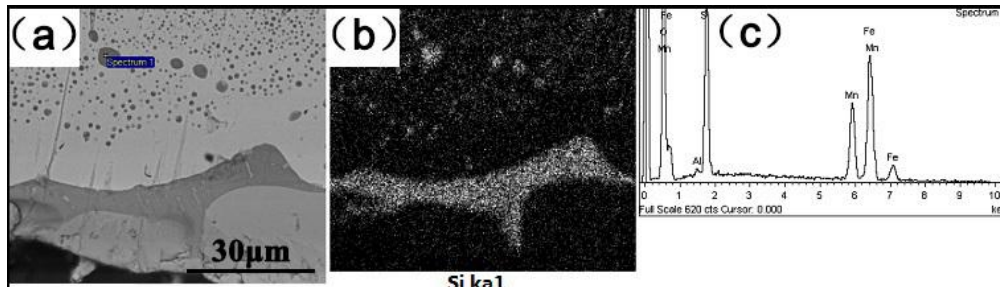
Figure 8. The results of Si distribution in iron matrix near scale by area scanning and energy spectrum. ( a ) The distribution of Si ‐ containing scale and particles; ( b ) the results of area scanning; ( c ) the results of EDS.